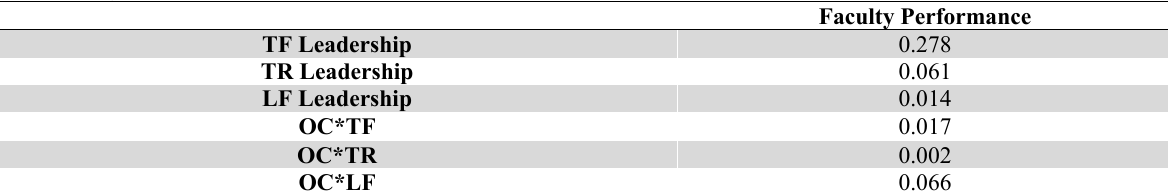
Effect Size ( f 2 ) Faculty Performance TF Leadership 0.278 TR Leadership 0.061 LF Leadership 0.014 OC*TF 0.017 OC*TR 0.002 OC*LF 0.066